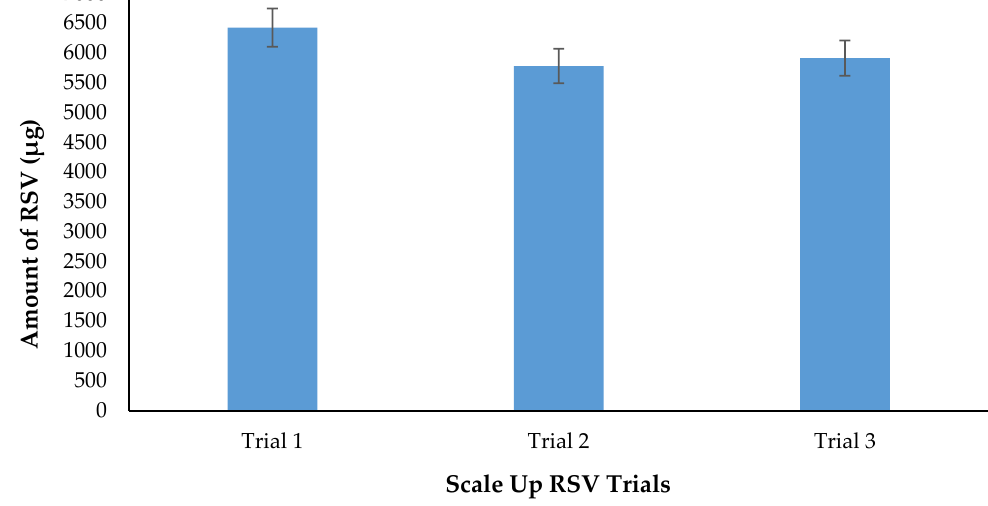
Figure 16. Dendrimer ‐ RSV scale up batches. Mean RSV concentration ( n = 3), p < 0.05.